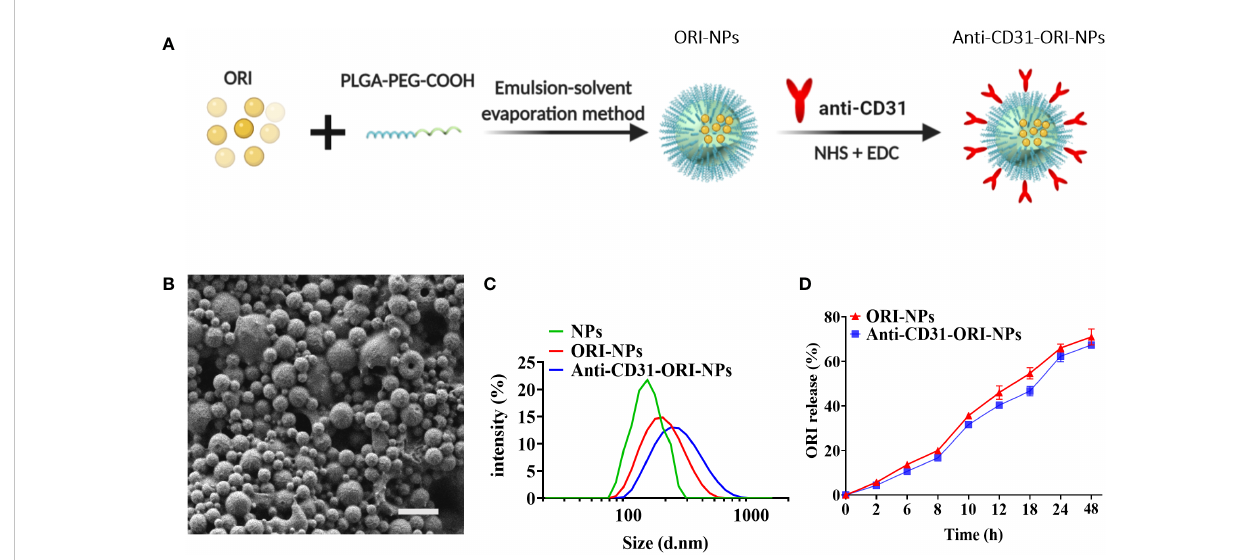
FIGURE 2 The characterization of NPs. (A) The preparation procedures of anti-CD31-ORI-NPs. (B) The morphology of NPs was observed by scanning electron microscopy. Bars:1 m m. (C) The NPs size was detected by dynamic laser scattering. (D) In vitro release of ORI from various NPs were determined by UV